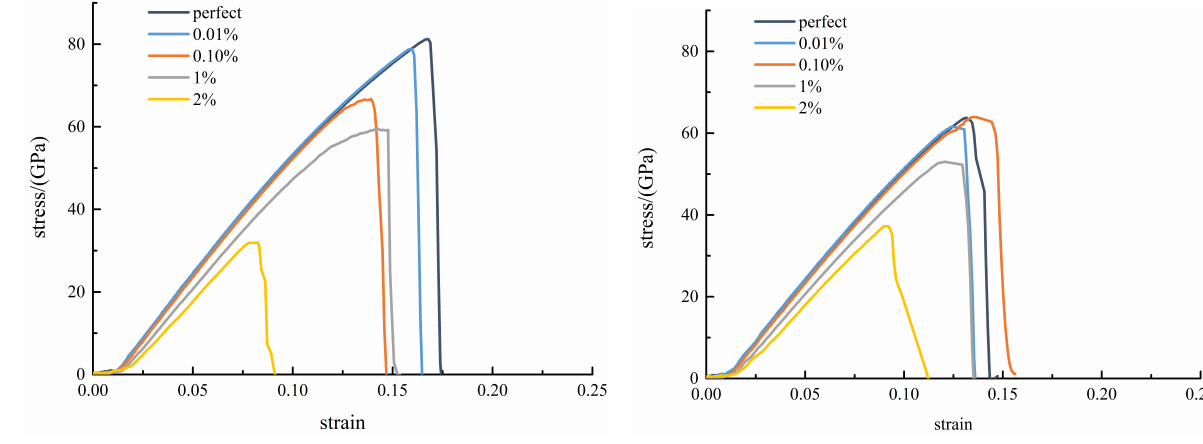
Figure 4: Stress-strain curve of BNNS at